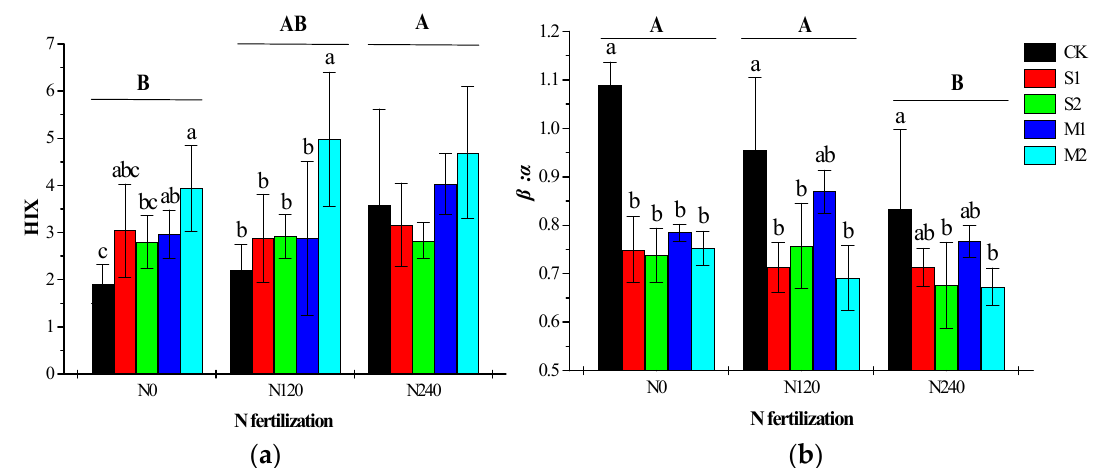
Figure 5. Fluorescence properties of water-extractable organic matter: ( a ) humification index (HIX) of water-extractable organic matter; ( b ) the ratio of fluorescence intensity of peak β to peak α ( β : α ) of water-extractable organic matter. Treatment abbreviations are defined in Figure 1. Different lowercase letters indicate significant differences among the five organic amendment treatments ( p < 0.05). Different uppercase letters indicate significant differences among the three nitrogen fertilization treatments ( p < 0.05).